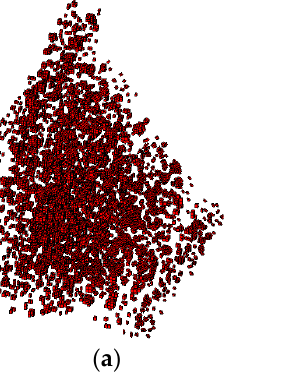
Figure 7. Finite element mesh diagram of dam concrete aggregate and ITZ elements, ( a ) Aggregate elements, ( b ) ITZ elements.